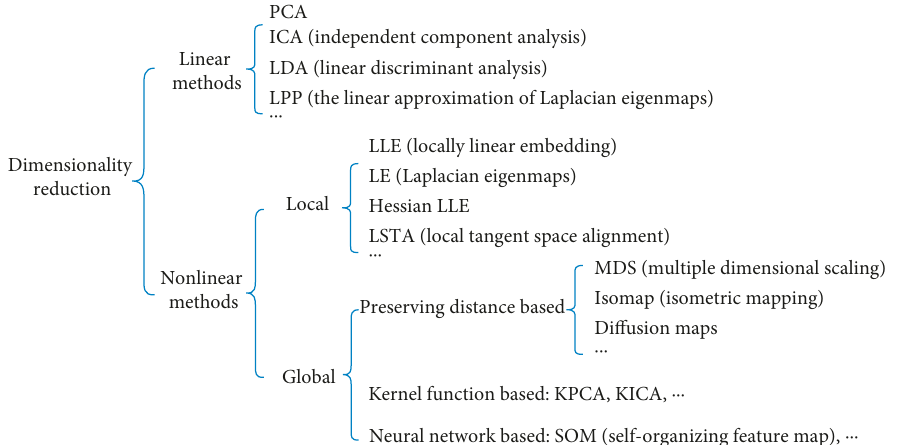
Figure 1: The classification chart of basic dimensionality reduction methods.